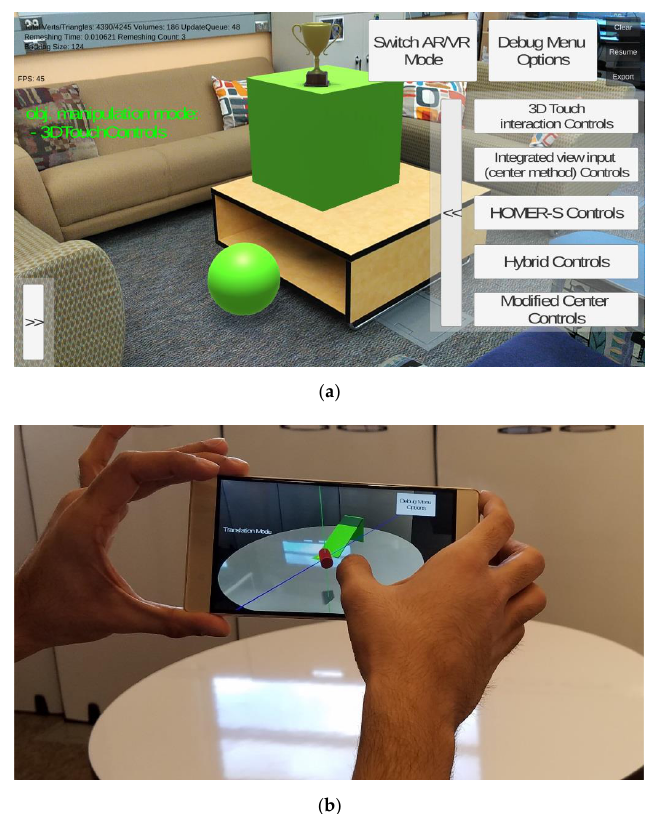
Figure 2. The test suite implementation. ( a ) Initial user interface screen; ( b ) user running a test